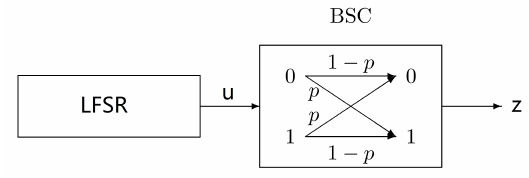
Figure 4: Model for a bitwise fast correlation